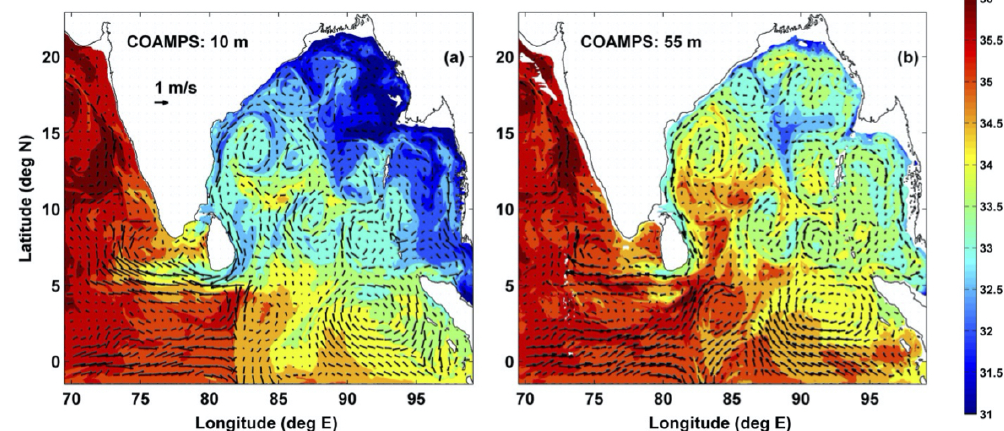
Figure 13. COAMPS velocity vectors (arrows) and salinity (psu, colour shading) at (a) 10m and (b) 55m on 18 December 2013. Modified from Wijeskera et al.